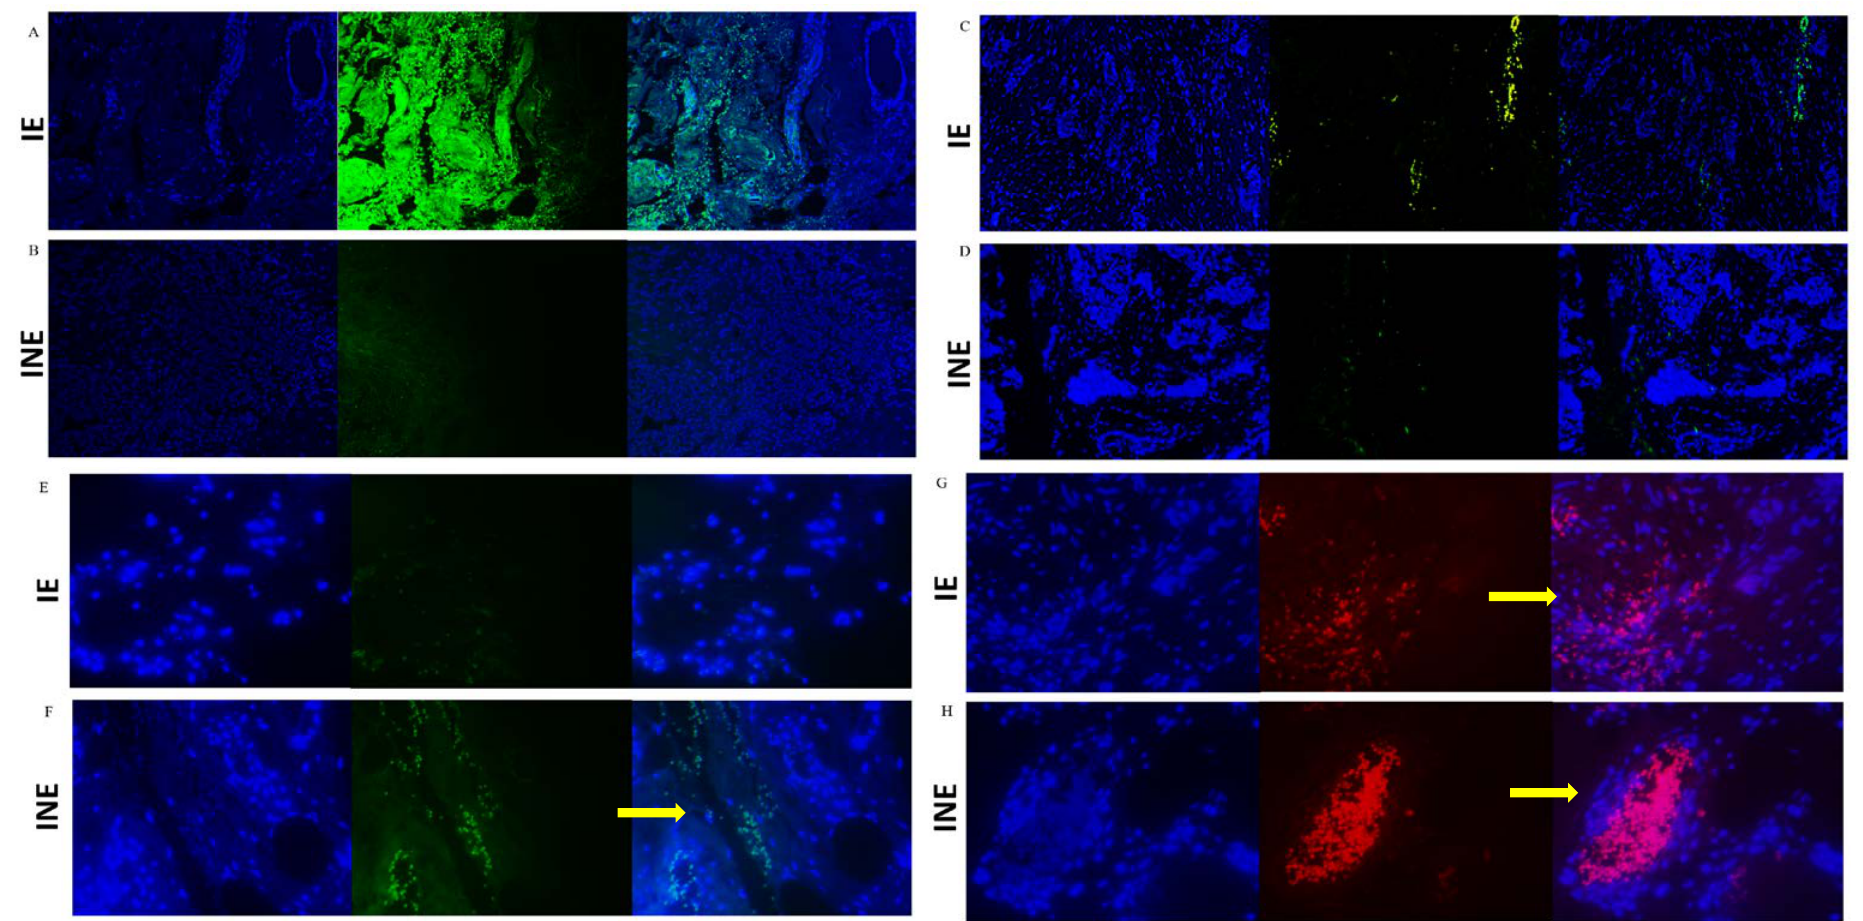
Figure 5. Immunostaining of TGF- β 1 ( A , B ), CTLA-4 ( C , D ), CD8+ lymphocytes ( E , F ), and CD4+ lymphocytes ( G , H ) in breast tumor biopsies from intermediate-risk patients exposed (IE) or unexposed (INE) to pesticides. Labeling was evaluated in breast tumors and infiltrating leukocytes (400×). The images sequentially represent (horizontal view) DAPI labeling, marker labeling, and the merge of DAPI + marker. The resulting images were merged in ImageJ to generate the final images. For all images: immunostaining in green for Alexa Fluor (positive staining), red for Texas Red (positive staining), and blue for DAPI (negative counterstaining). The yellow arrows indicate the labeled areas.